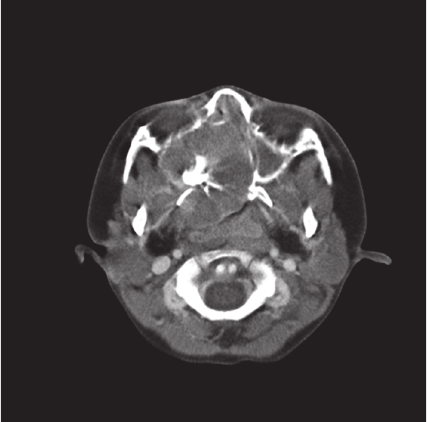
Figure 2: Postcontrast axial CT scan shows various portions of little enhancement within a marked heterogeneous enhancement mass and weaker intensity compared to the facial muscles.